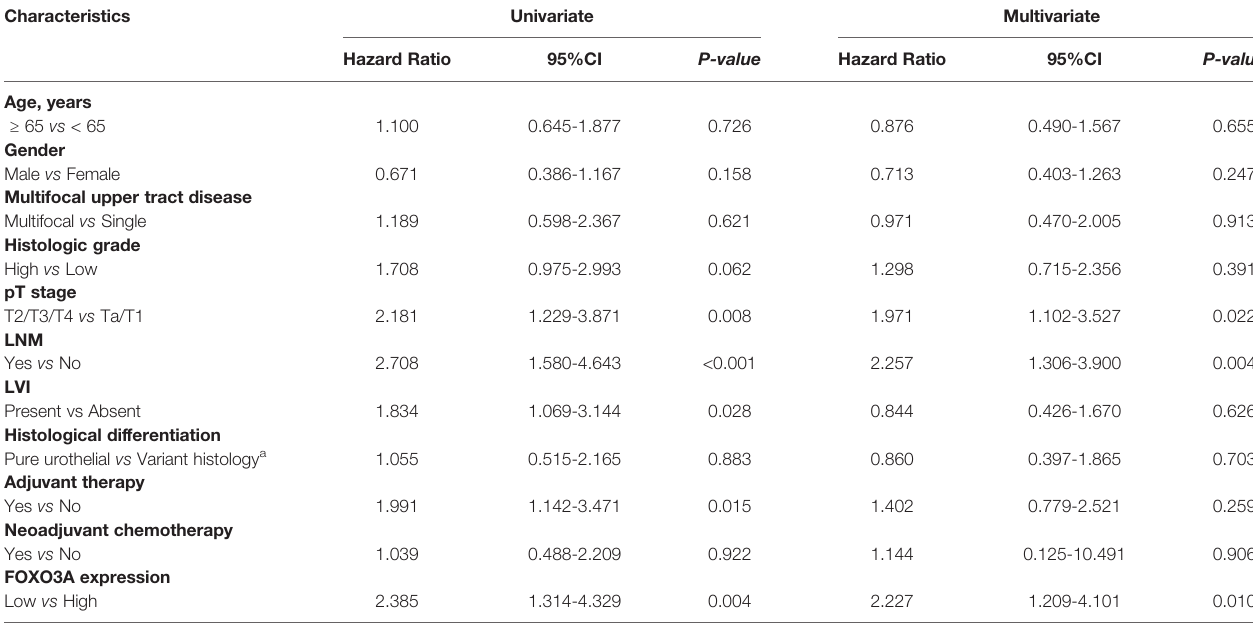
TABLE 3 | Univariate and multivariable analyses assessing the association between predictor variables and recurrence among 107 patients for UTUC.